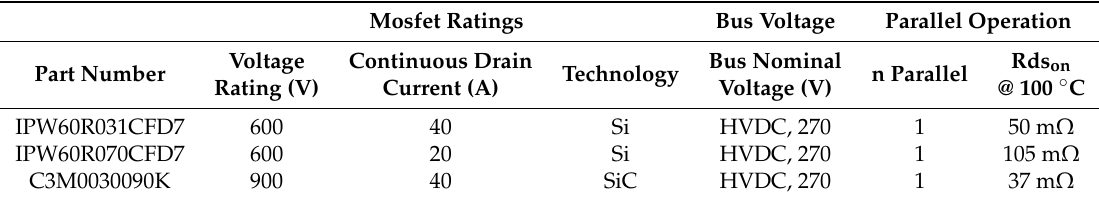
Table 1. HV MOSFETs